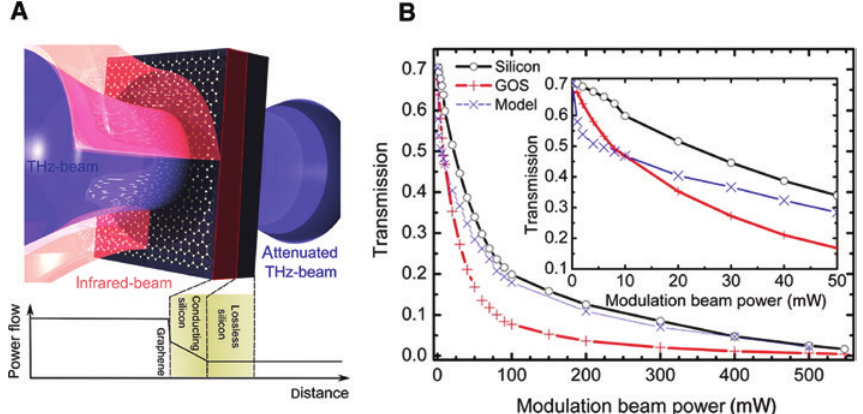
Figure 1: (A) Experimental sketch of the experiment. The pump beam induced photo-generated carriers in the silicon-graphene region, thus modifying the transmission for the THz beam. The effect of graphene transfer on silicon is evident in (B), where graphene on silicon (GOS) shows a stronger absorption and therefore allowed higher modulation depths at lower pump power levels. (Adapted with permission from P. Weis et al. ACS Nano 6, 9118-9124, 2012, Ref. [41]. Copyright 2012 American Chemical